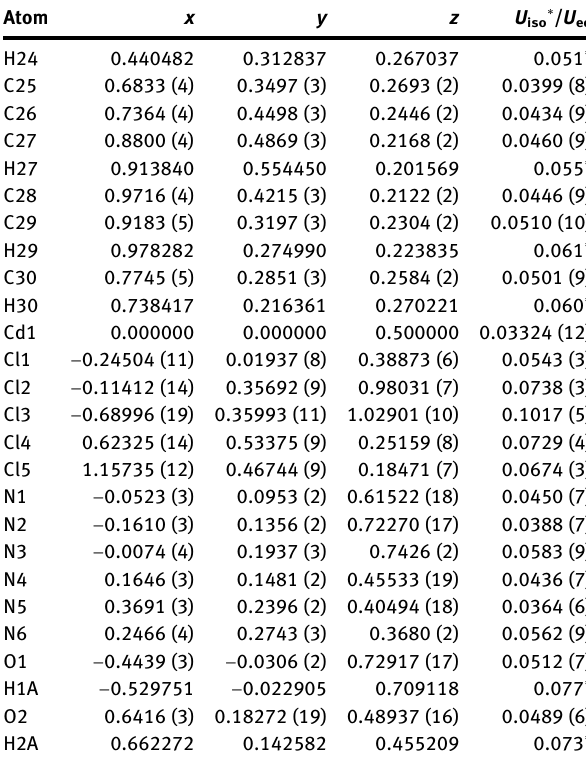
Table  : Fractional atomic coordinates and isotropic or equivalent isotropic displacement parameters (Å 